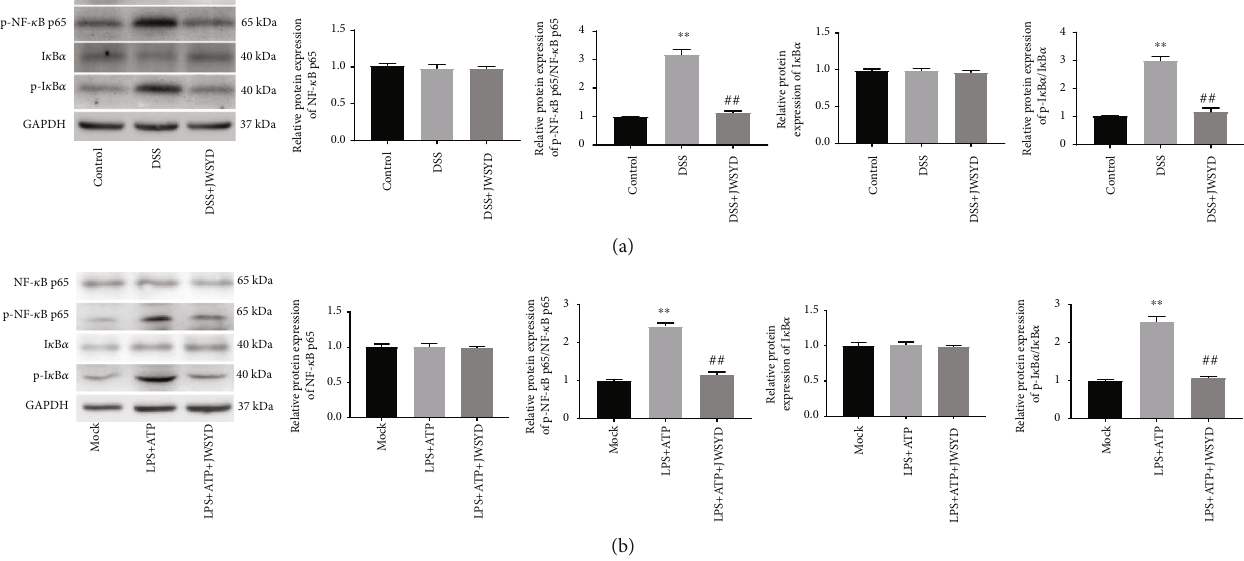
Figure 5: Jiaweishaoyao decoction (JWSYD) suppressed the NF- κ B pathway. (a) Protein levels of NF- κ B pathway-associated proteins (NF- κ B p65, I κ B α , p-NF- κ B p65, and p-I κ B α ) were detected by western blot in colon tissues. ∗∗ P < 0 : 01 compared with the control group; ## P < 0 : 01 compared with the DSS group. (b) Protein levels of NF- κ B pathway-associated proteins (NF- κ B p65, I κ B α , p-NF- κ B p65, and p-I κ B α ) were detected by western blot in LPS-induced RAW264.7 cells. ∗∗ P < 0 : 01 compared with the mock group; ## P < 0 : 01 compared with the LPS+ATP